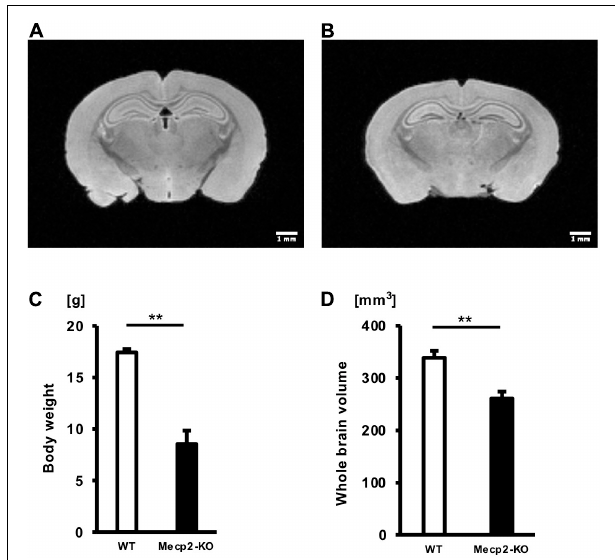
FIGURE 1 | Mean body weights and whole-brain volumes for Mecp2 -KO mice and WT mice. T2-weighted images of WT mice (A) and Mecp2 -KO mice (B) are shown. Loss of Mecp2 leads to a drastic decrease in body weight (g) (C) and whole-brain volume (mm 3 ) (D) . Statistical test: Welch’s t -test. n = 4 mice per group. ** p < 0.01. TABLE 1 | Results of each statistical test of Figure 1 . Mann-Whitney U Welch’s test t -test Body weight 0.0286* 0.0049** Whole brain volume 0.0286*